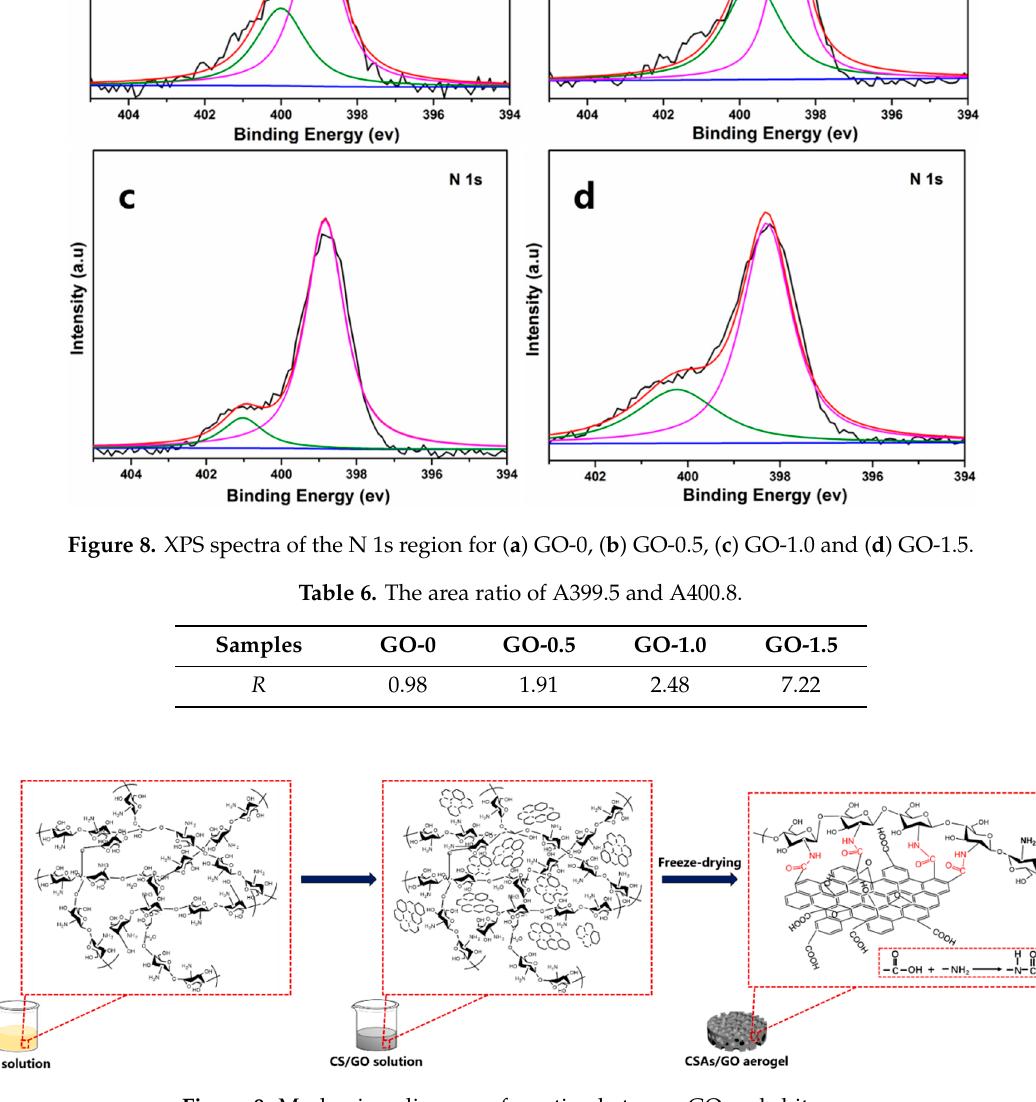
Figure 8. XPS spectra of the N 1s region for ( a ) GO-0, ( b ) GO-0.5, ( c ) GO-1.0 and ( d ) GO-1.5. Table 6. The area ratio of A399.5 and A400.8.